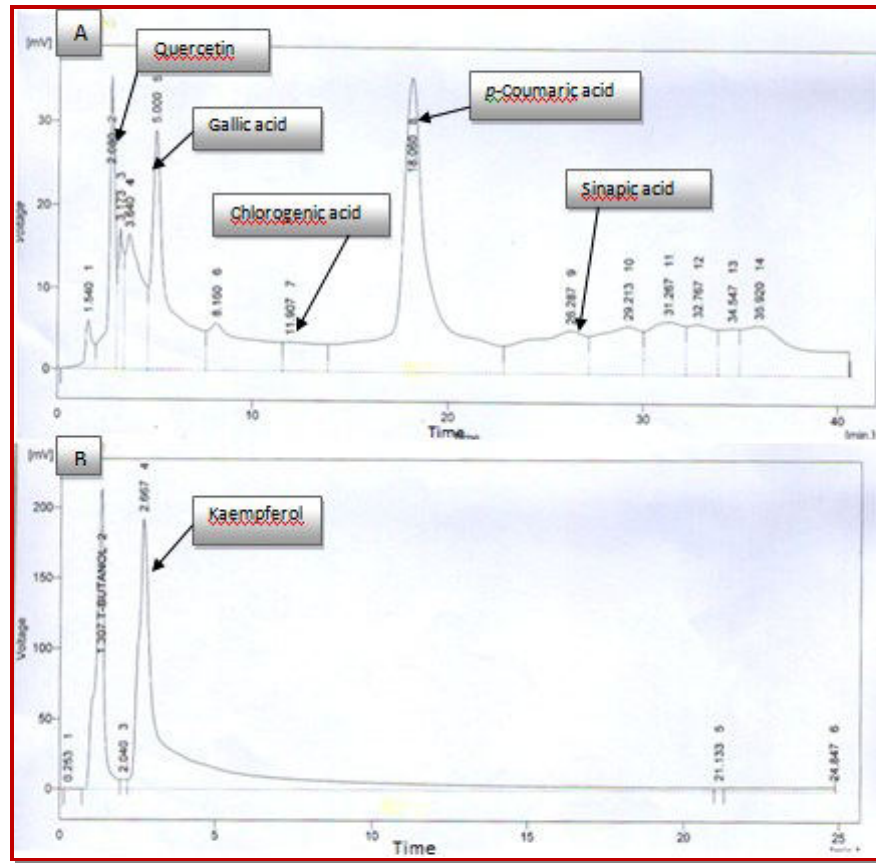
Figure 2: HPLC analysis of aqueous methanolic extract of C. murale. A) Detection at 280 nm; B) Detection at 248 nm